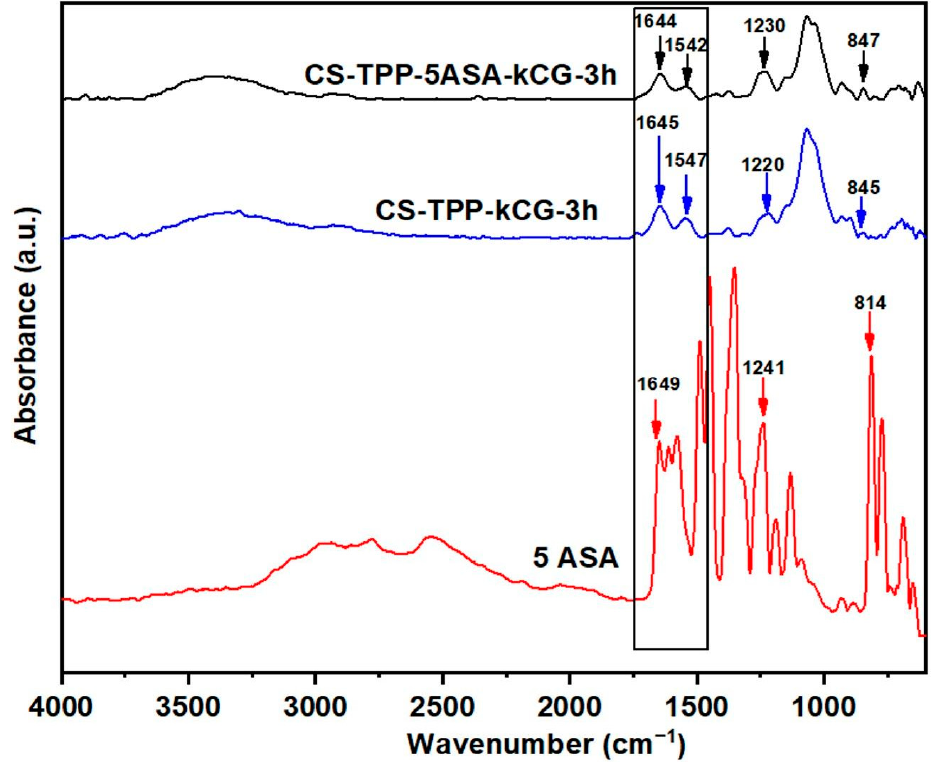
Figure 3. FT-IR spectra of drug loaded and unloaded CS-TPP-kCG-3h particles and 5ASA. This peak shift attributed to amide II vibration was detected in all of the CS-TPP-kCG beads FT-IR spectra (Figure 4). The loading drug in the CS-kCG bicomponent particles was confirmed by the increase of the peak intensity assigned to the carboxyl group stretching vibration in all of drug loaded CS-TPP-kCG beads (1642–1645 cm − 1 ) and by the presence of the C aromatic -N stretching vibration (1230–1249 cm − 1 ) from the drug structure. Additionally, the new peak at ~850 cm − 1 attributed to C–H out of plane bending vibrations confirmed the encapsulation of